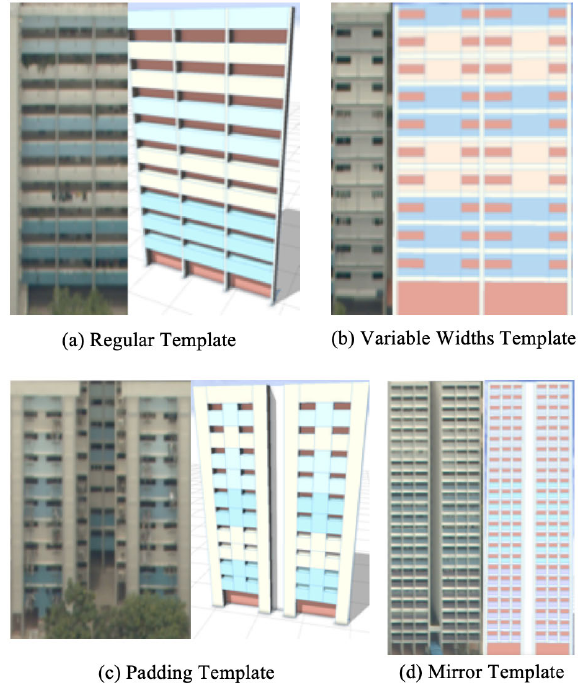
Figure 13. Typical procedural fac¸ade templates reality-based on Singapore’s HDB